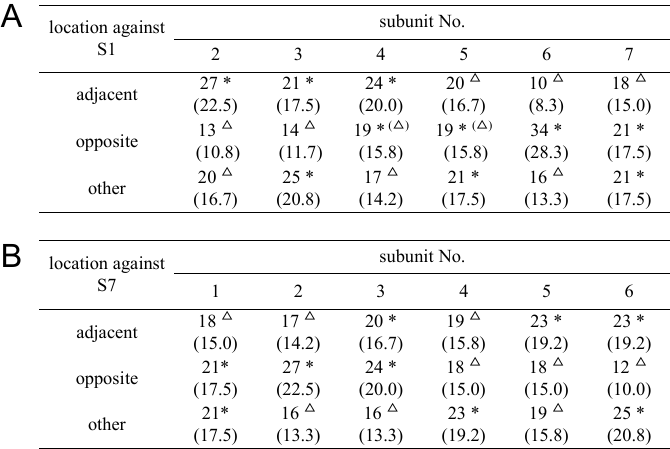
Table 1 Probability of the subunit locating on the position of “adjacent”, “opposite” and “other” in the negative TEM images of the Hlg pore